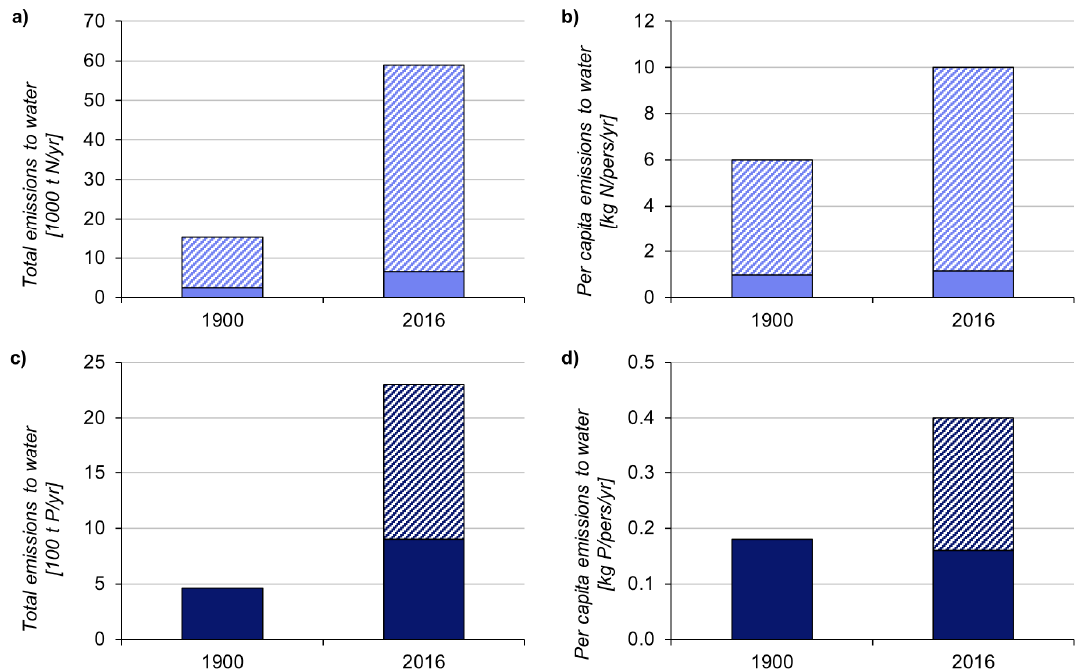
Figure 7. Nitrogen emissions from point (solid bars) and diffuse (hatched bars) sources to water in 1900 and 2016, ( a ) total and ( b ) normalized to total population; and phosphorous emissions from point (solid bars) and diffuse (hatched bars) sources to water in 1900 and 2016, ( c ) total and ( d ) normalized to total population. No data regarding diffuse phosphorous emissions in 1900 was available.